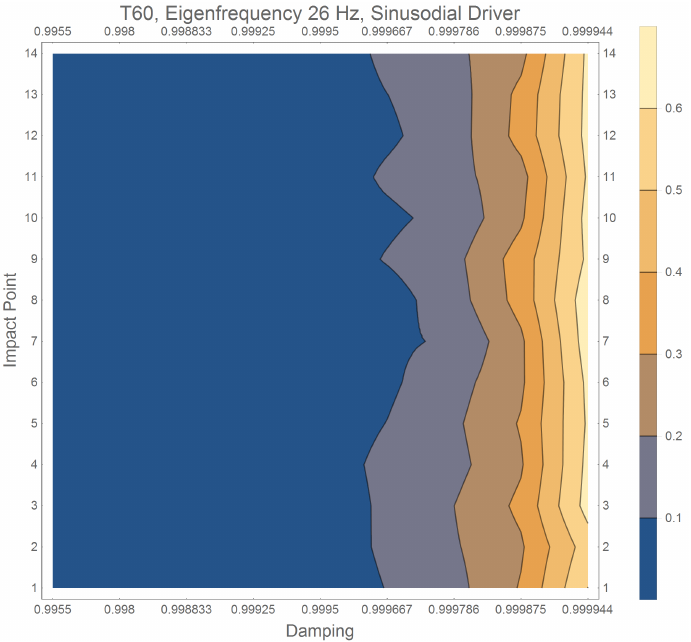
Figure 3. T60 of knocking sounds on 14 impact positions at the piano bridge for nine damping strength as used in the simulation, with decreasing strength from left to right. The measured T60 of the raw piano soundboard is around T60 ∼ 0.3 s, the T60 for the finished soundboard are around T60 ∼ 0.6 s. Therefore, the displayed range is up to the maximum damping of regular piano soundboards. The minimum damping is decreased to below T60 ∼ 0.1 s to show the impact of damping on